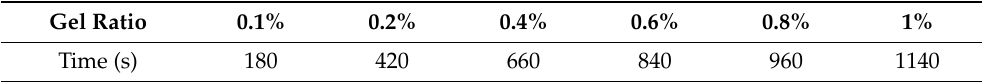
Table 5. Temperature resistance time